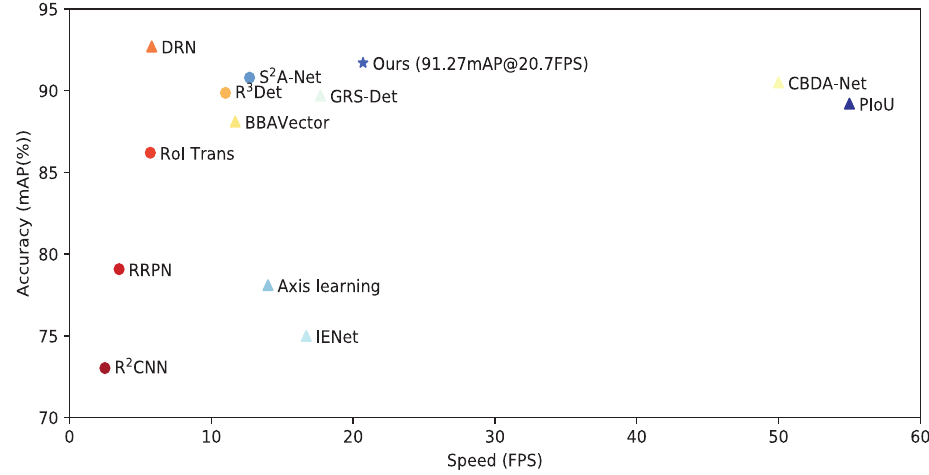
Figure 9. Accuracy versus speed on the HRSC2016